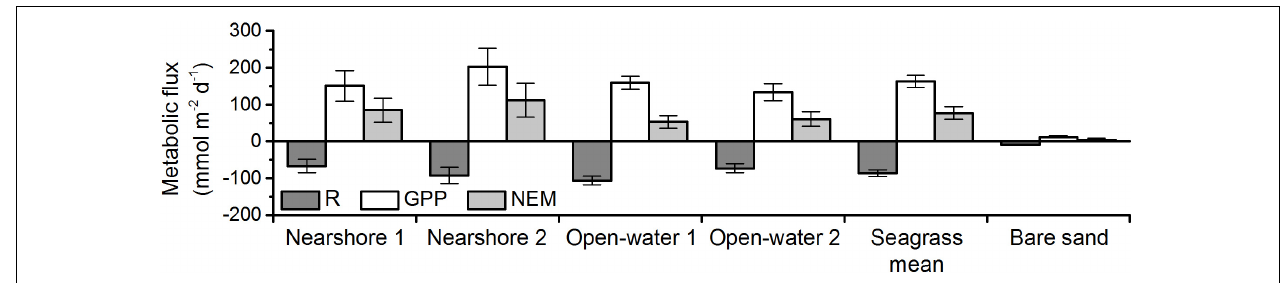
FIGURE 6 | Respiration (R), gross primary production (GPP), and net ecosystem metabolism (NEM) of seagrass meadows and bare sands in May of 2016 and 2017. Errors represent standard error. The number of replicates for each measurement is presented in Table 2 . Seagrass mean NEM was significantly greater than that of bare sand (two-sample t -test; p <